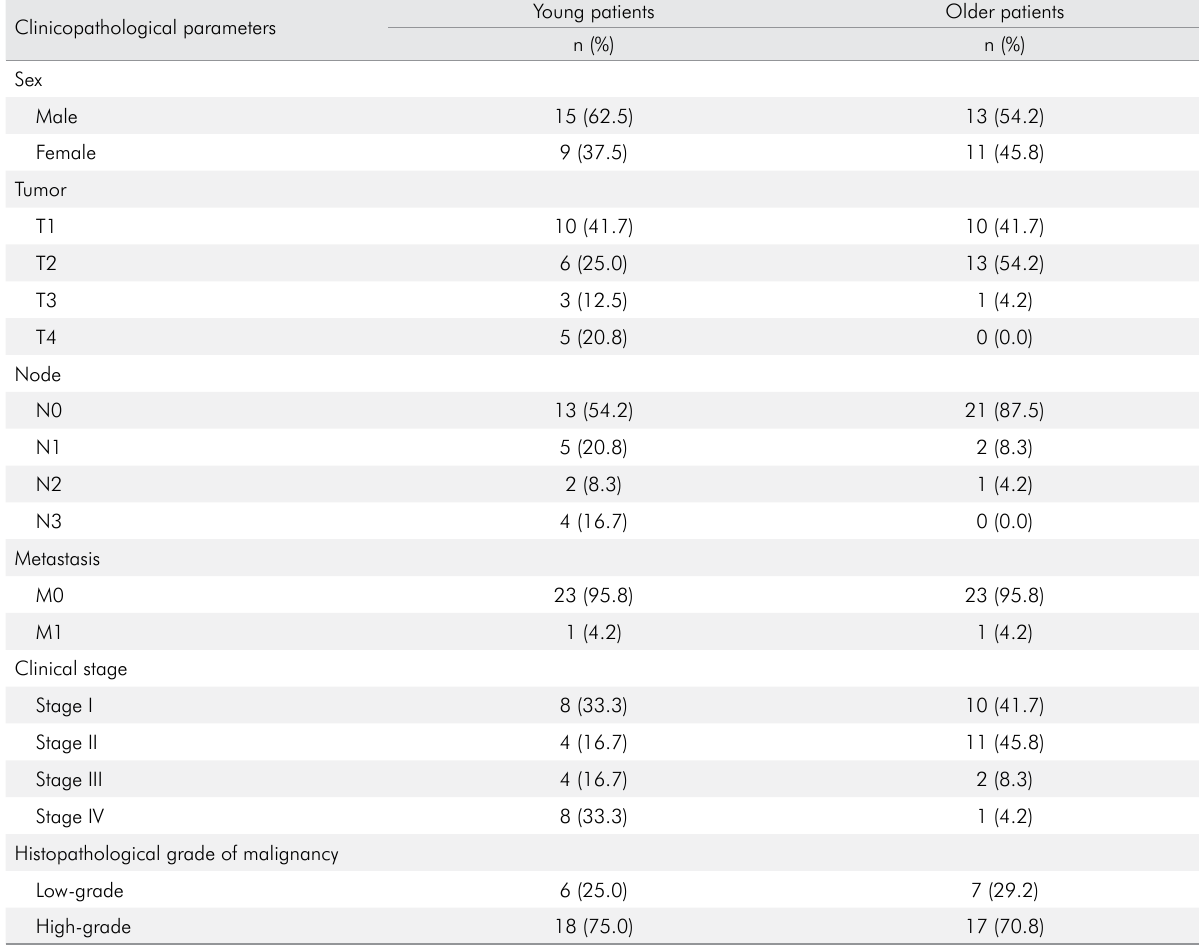
Table. Distribution of cases of OTSCC in young (≤ 45 years) and older (≥ 60 years) patients according to clinicopathological